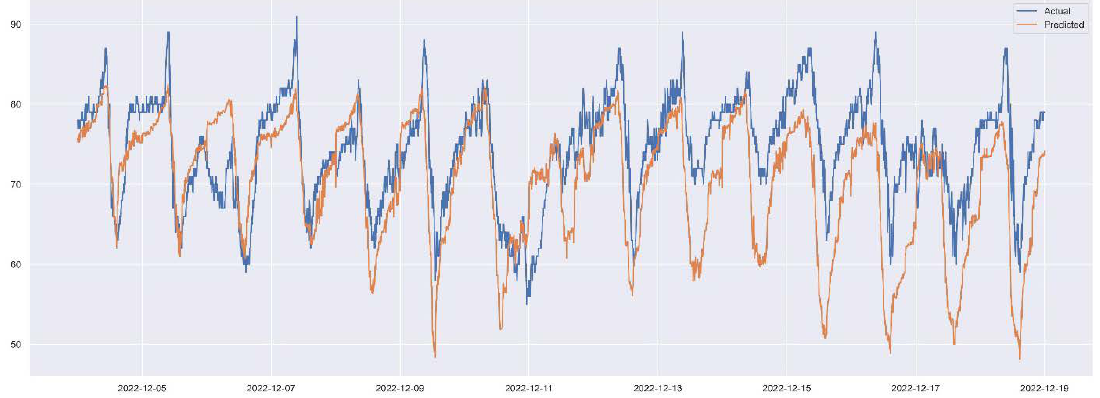
Figure 20. Prediction of humidity inside the hive using gradient boosted decision trees. Zooming in the test